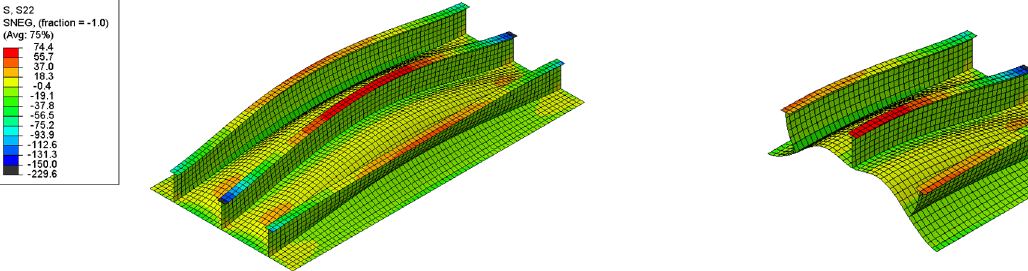
Figure 7. Longitudinal stress distribution (S22 in the model’s convention) over the topside wing tank stiffened panel: left , full model; right , section cut.